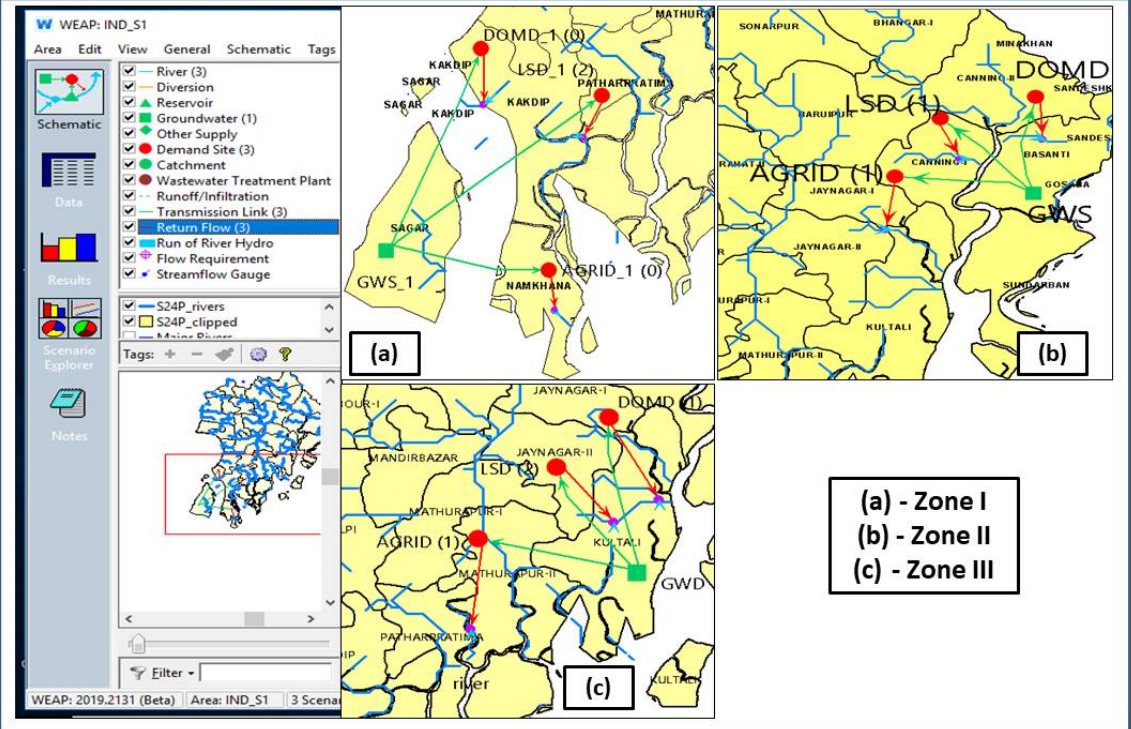
Figure 3. Hydrological simulation model in the study area (Sundarbans).